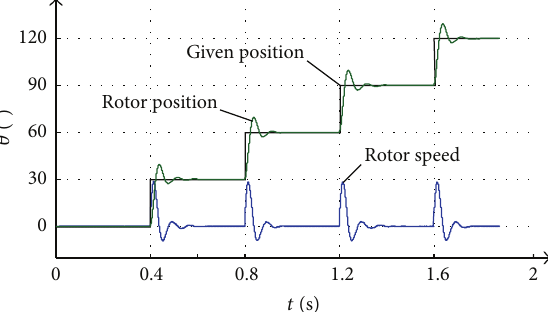
Figure 8: Position and speed curve under point